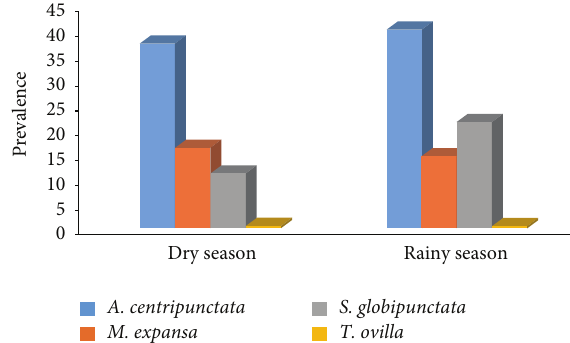
Figure 2: Seasonal variation of prevalence of anoplocephalids in sheep. Dry season extends from November to May, while rainy season extends from June to